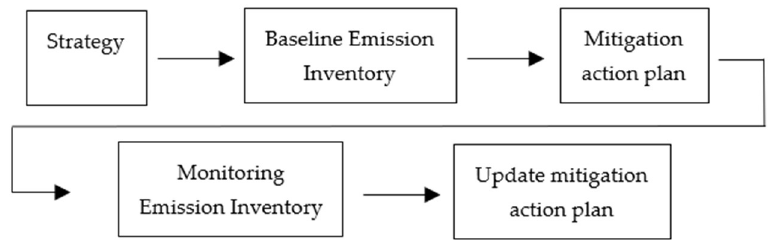
Figure 1. Flowchart of SEAP process.